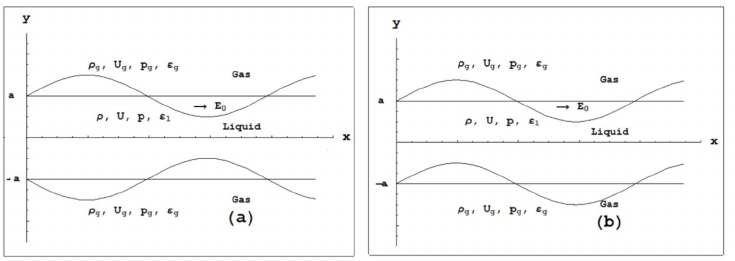
Figure 1. Description of the system for ( a ) Symmetric and ( b ) Antisymmetric